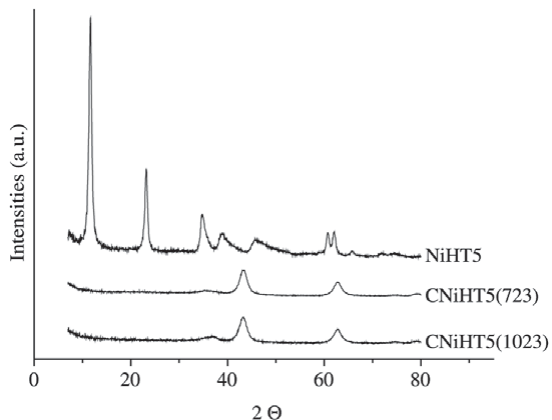
Figure 2. X-ray diffractograms for NiHT5 as-synthesized and cal- cined at 723 K (CNiHT5(723)) and 1023 K